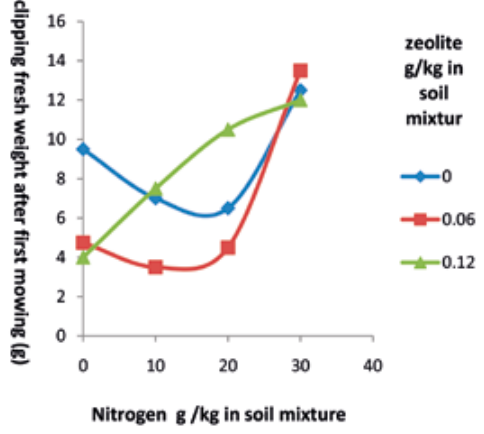
Fig. 1 - Effect of nitrogen and zeolite on clipping fresh weight after first mowing (g) of Festuca arundinaceae